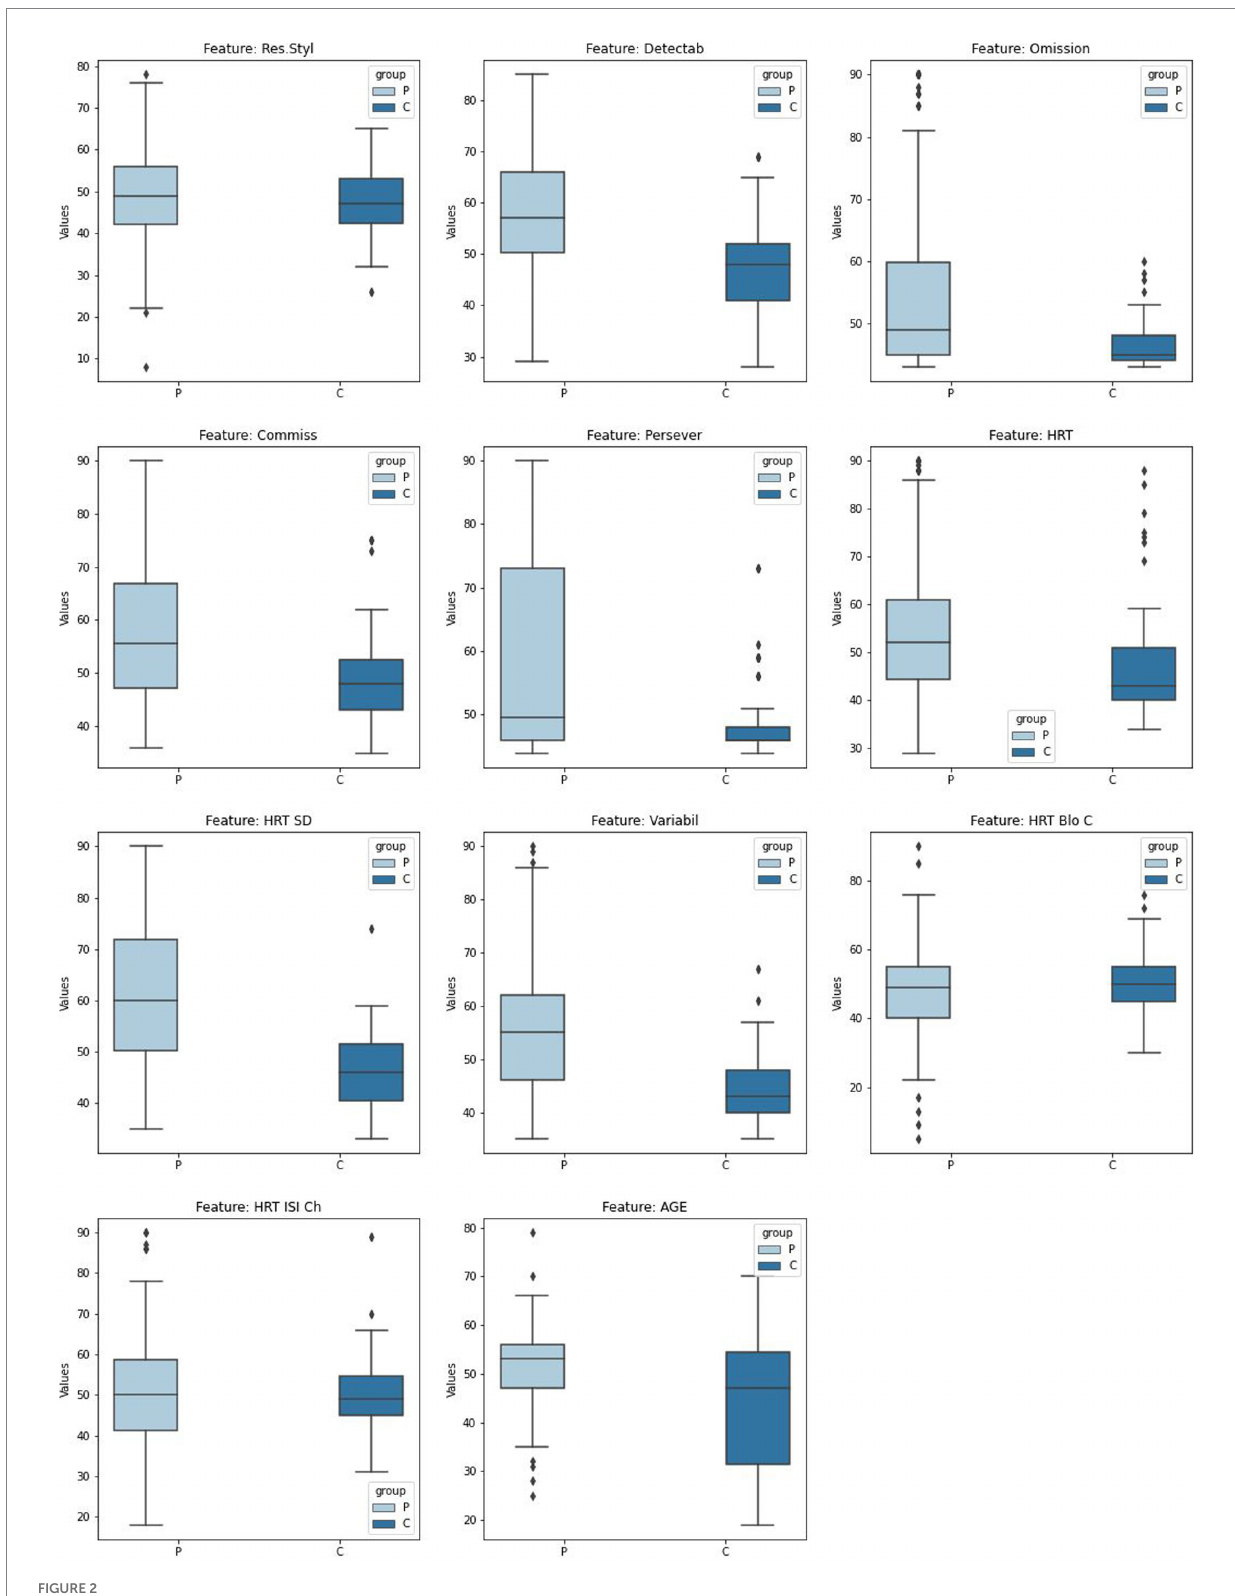
FIGURE 2 Box plot numerical features analysis by groups. Box plots for continuous variables by groups. The horizontal axis shows the groups, and the vertical axis shows the variable